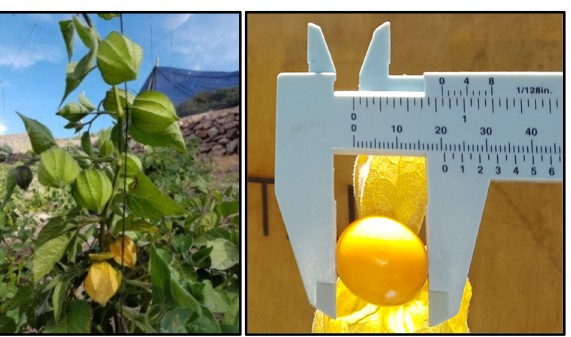
Figure 1. Physalis peruviana fruit from the Arid Andean Region of Northern